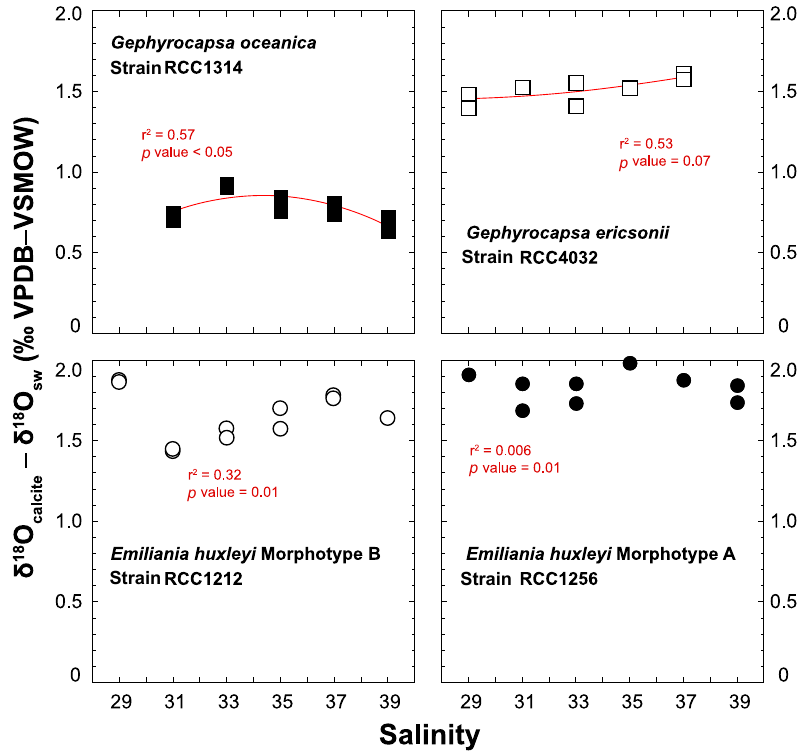
Figure 5. Effect of ambient salinity on the oxygen isotope composition of coccolith calcite. The variations in the isotopic composition of the coccolith are relatively minor, less than 0.35‰ for a considered strain with our salinity treatments. The spread of isotopic data is slightly larger for RCC1212 E. huxleyi (0.5‰), but there is no salinity dependence on growth rates observed for this strain. For reference, the Kim and O’Neil’s calcite composition is around 0‰ VPDB. At 15 ◦ C, the vital effect can thus be quantified by the δ 18 O calcite – δ 18 O sw offset. These positive values indicate that all the investigated species belong to the “isotopic heavy group”. All fits (red lines) correspond to a second-order polynomial law (see Table